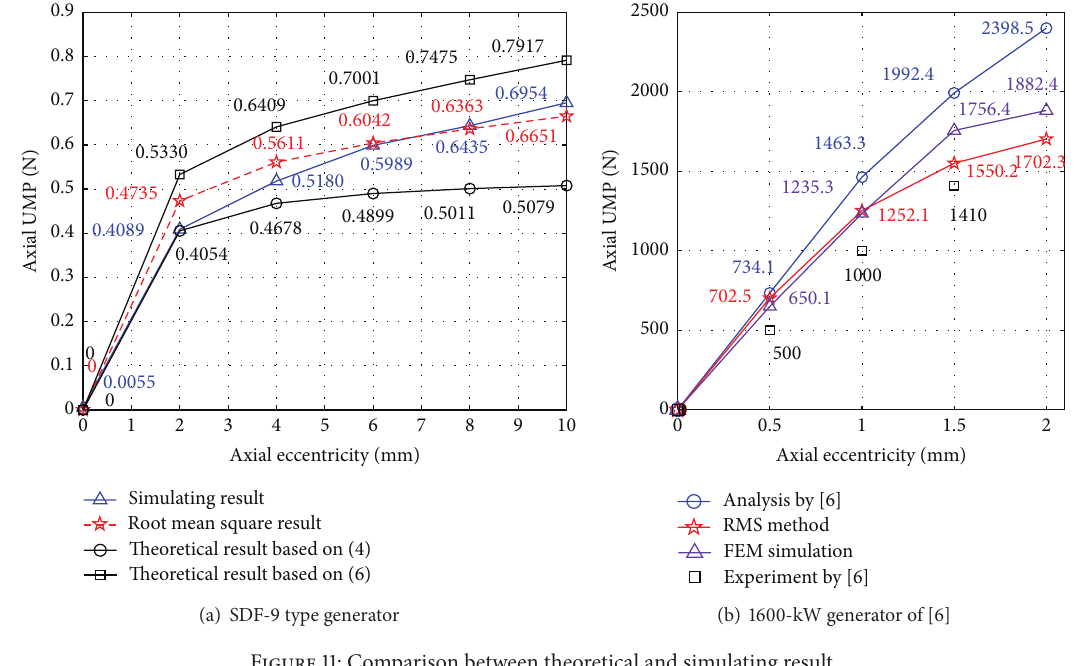
Figure 11: Comparison between theoretical and simulating result.